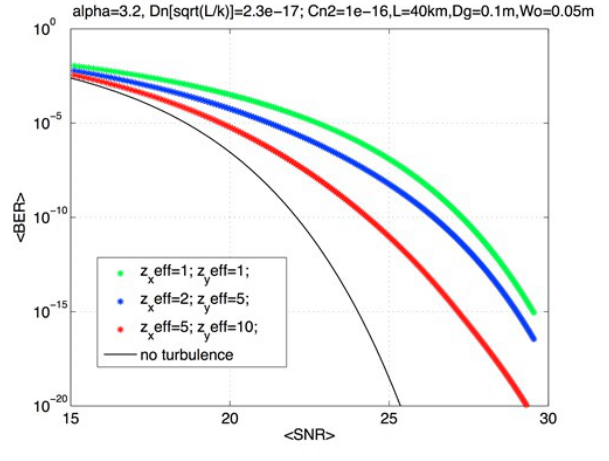
Figure 20. Mean BER as a function of mean SNR for several sets of anisotropy factors (shown as z x eff and z y eff in the legend) with α = 3.2. Reprinted with permission from Reference